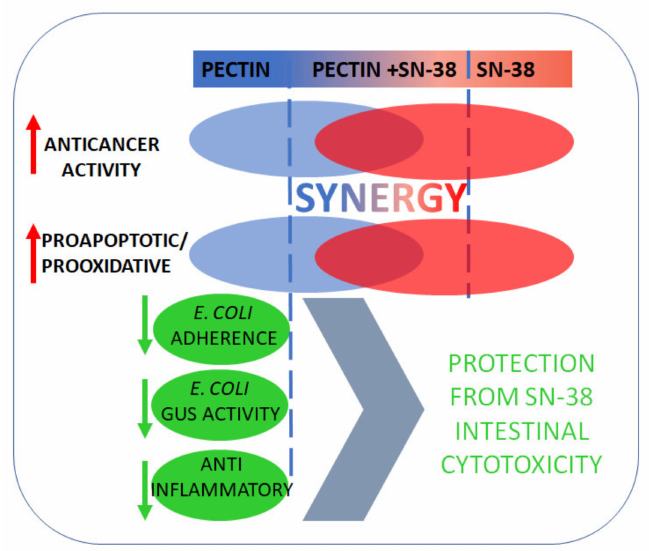
Figure 10. Schematic representation of activities of novel apple pectin in colon cancer cells.